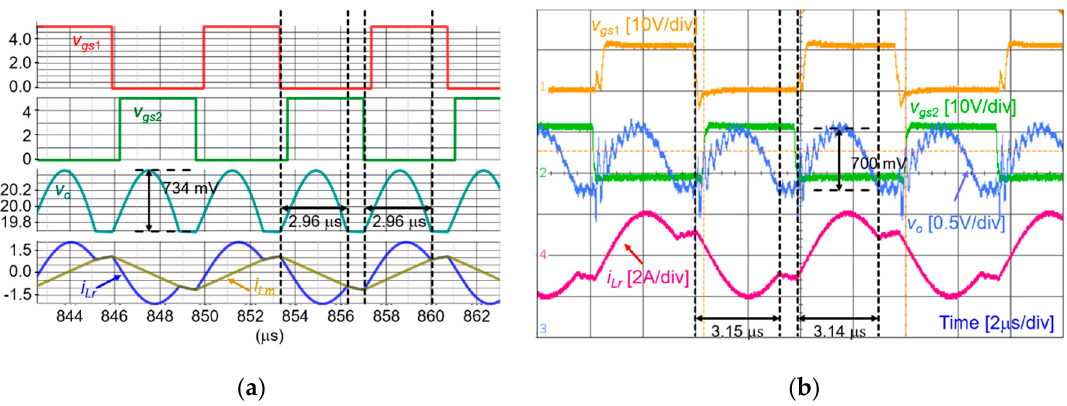
Figure 18. Matched secondary side leakage inductances at full load in steady-state operation ( a ) simulation results and ( b ) experiment results. ( a ) simulation results and ( b ) experiment